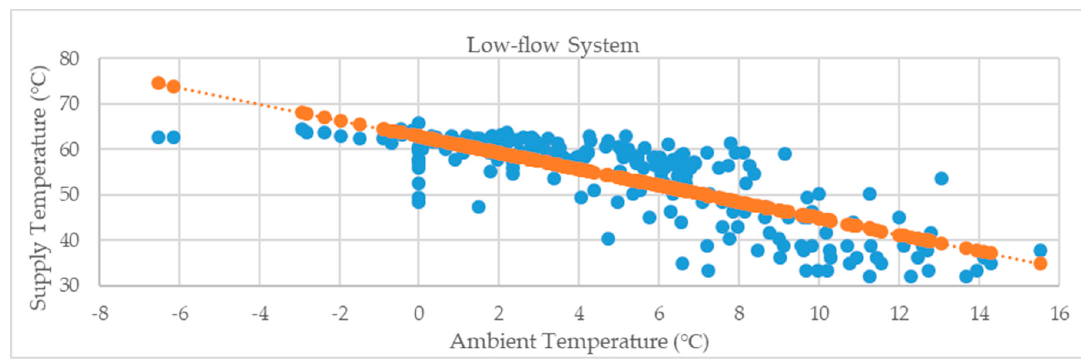
Figure 9. The proposed weather compensation control of the supply temperature (orange line) under low flow system operation presented via a linear regression analysis.